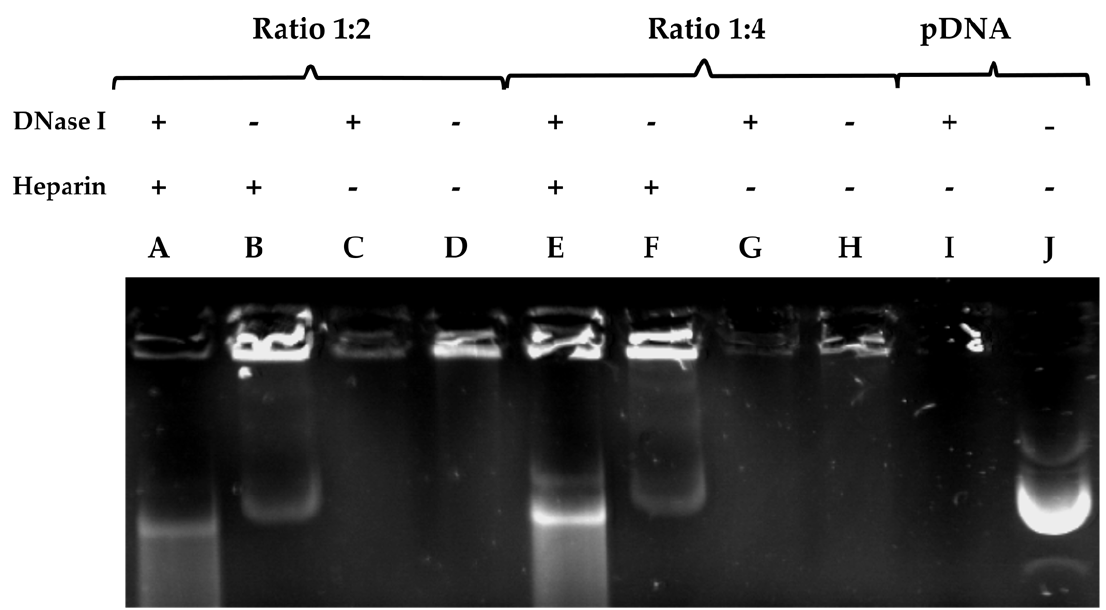
Figure 2. pDNA liberation assay from varying plasmid/PDL ratios using heparin. DNA complexes were formed with PDL at different ratios and run on a 0.8% agarose gel electrophoresis stained with GreenSafe. The protective properties of PDL were assessed after heparin released the DNA from the complex and DNase 1 was then allowed to cleave it. In columns A–D a plasmid-DNA ratio of 1:2 was inserted. Column A was run with the addition of DNase 1 and heparin. Column B only contained heparin and column C only contained DNase 1. In column D only the plasmid-DNA complex was inserted. Columns E–H were run with a plasmid-DNA ratio of 1:4. Column E was run with the addition of DNase 1 and heparin. Column F only contained heparin and column G only contained DNase 1. Column I only contained the plasmid-DNA complex. Column J was a positive control whereas only the naked DNA was inserted. + or − symbols indicate the presence or absence of heparin or DNase I.